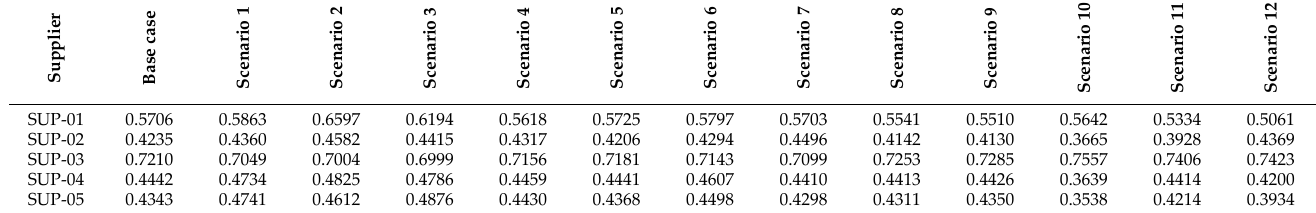
Table 11. The prospect values of suppliers for all scenarios.